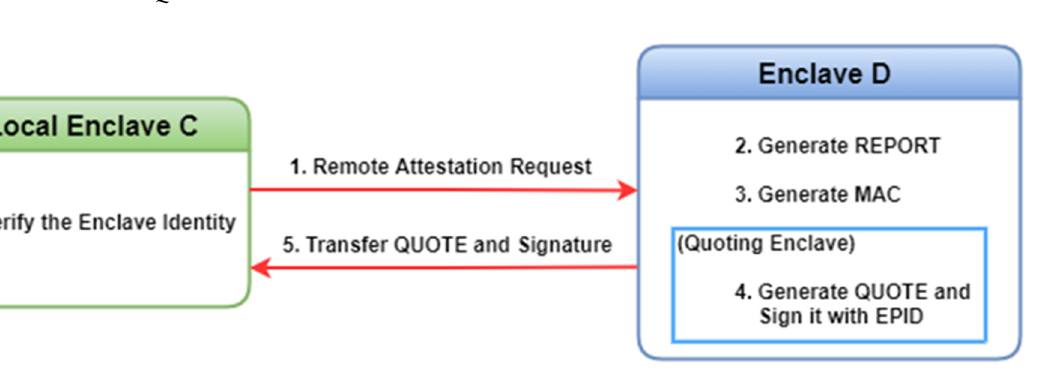
Figure 3. SGX attestation flow of remote attestation.